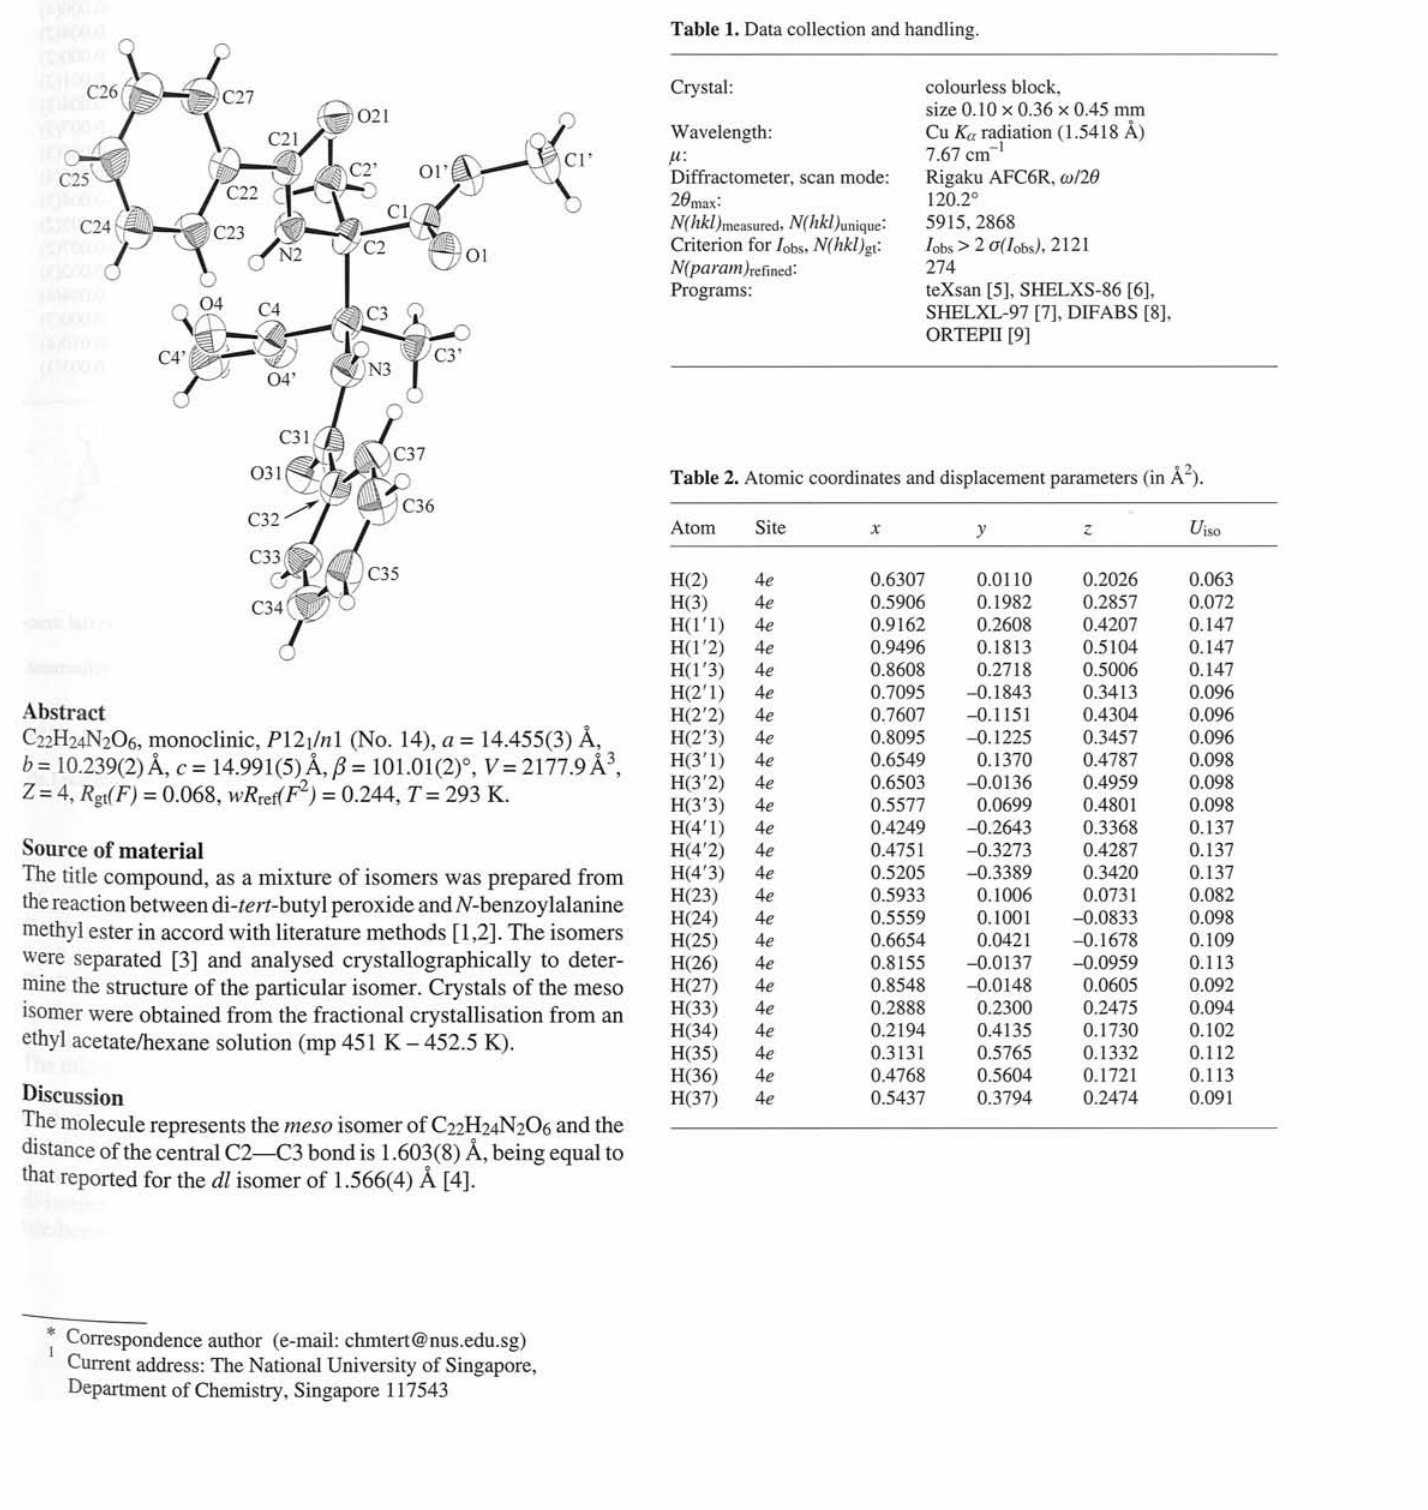
Table 2. Atomic coordinates and displacement parameters (in Â